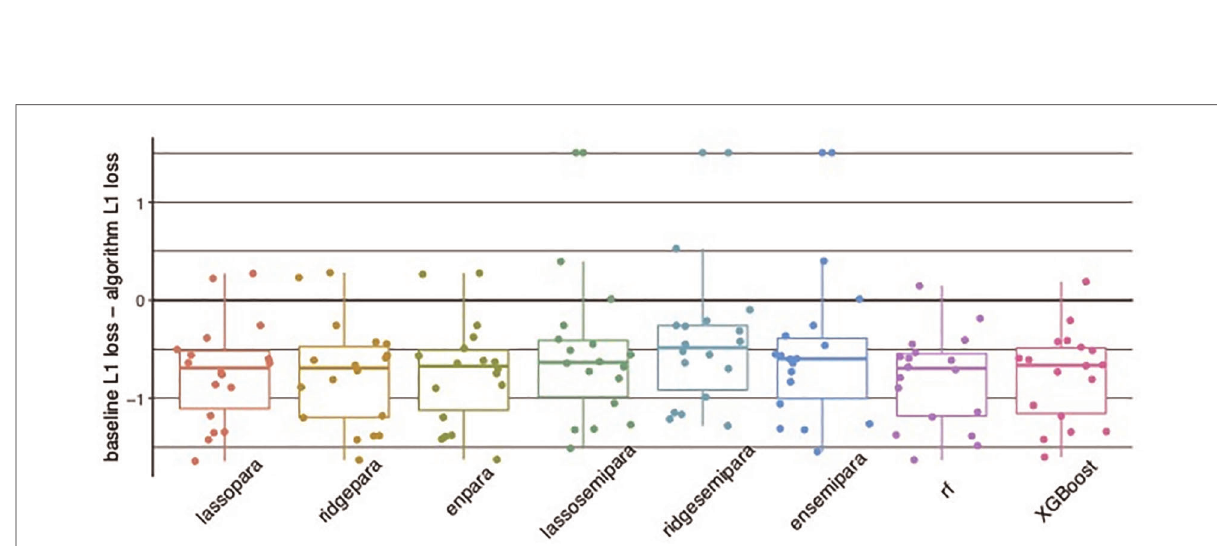
FIGURE 4 Heatmap showing the error rates of machine learning prediction algorithms across the 18 Functional Independence Measurement (FIM) scores in TBI patients. Statistical algorithms included parallel and semi-parallel ordinal regression with lasso, ridge, or elastic net penalty, random forest, and XGBoost.